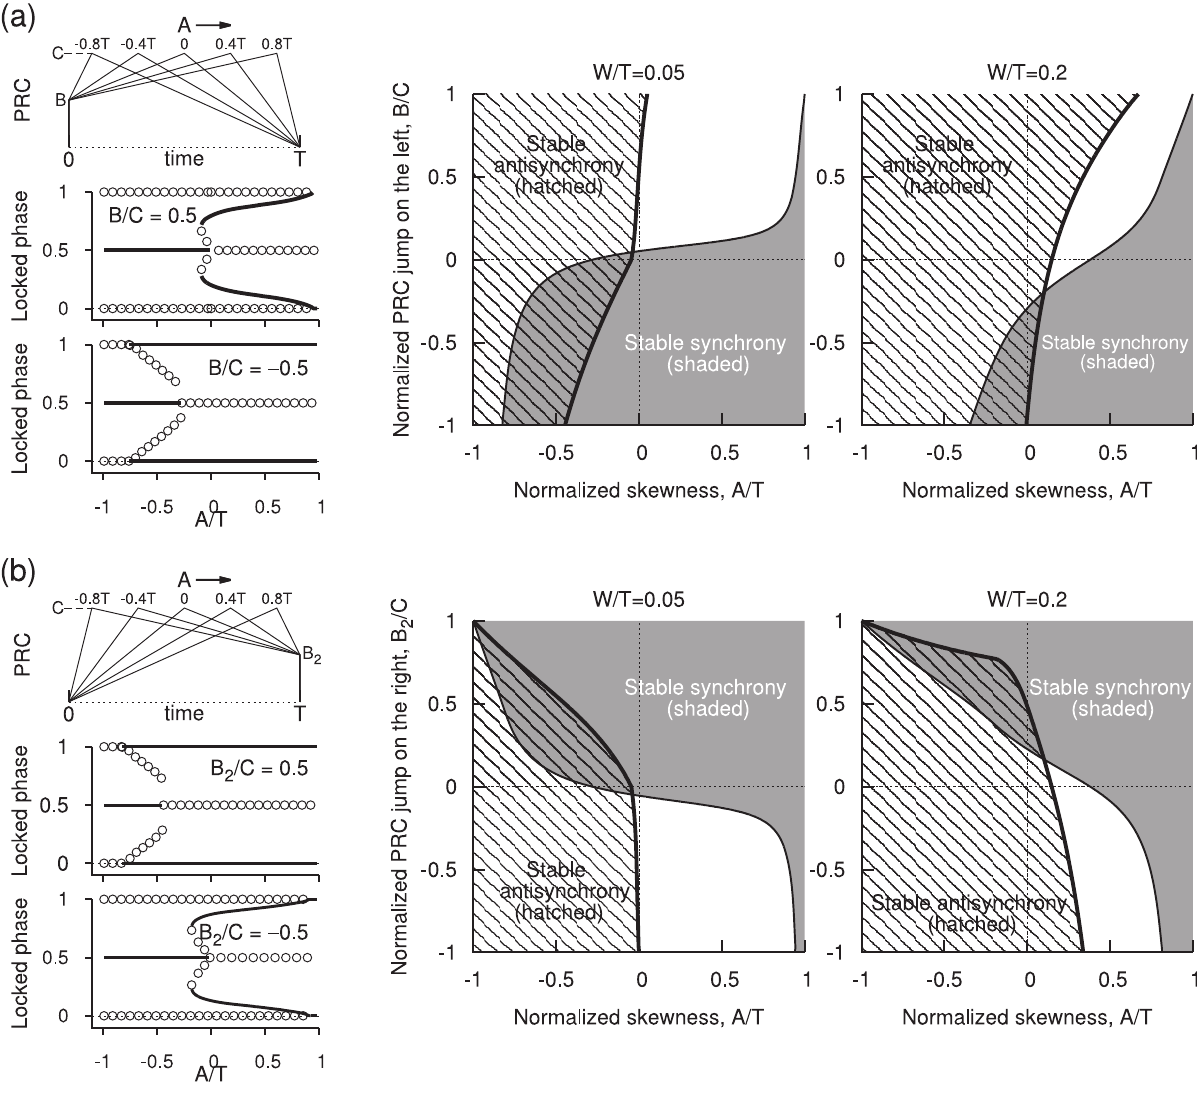
Figure 5. Effect of skewness on the PRCs that have left side jump (a), and those that have right side jump (b). The left jump PRCs are parametrized by B = C and the right jump PRCs are parameterized by B 2 = C . (a) A sample set of PRCs as the skewness A is moved from negative to positive levels is illustrated in the left column along with one-parameter bifurcation diagrams at two different levels of B = C as the skewness is increased ( W = T ~ 0 : 05 ). For positive jump synchrony is mostly unstable, and at large skewness even the antisynchrony is destabilized. But for negative jump skewness helped stabilize synchrony. On the right parameter planes depicting stability regions in the plane of skewness and jump are illustrated at different levels of W = T . (b) Same as in (a) but for right side jump PRCs ( B = C ~ 0 ). a 3 = a 2 ~ 0 : 2234 : increasing W = T , the upstroke broadens at a lower rate than the downstroke, and consequently the stabilizing effect of the upstroke dominates resulting in boundary of the stable antisynchrony becoming sensitive for W = T . At large W = T , most of the parameter space is filled with antisynchronous state [Fig. 4(b)]. Unlike the case of zero spike width, the stable near-zero phase- locked state and the synchronous state are well separated [Fig. 4(c)], and a bistability between a non-zero phase-locked state and the antisynchronous state is found for large left PRC jumps. Increasing the frequency causes bistability between synchronous and antisynchronous states [Fig. 4(d)], before the synchrony loses stability [Fig. 4(e)].